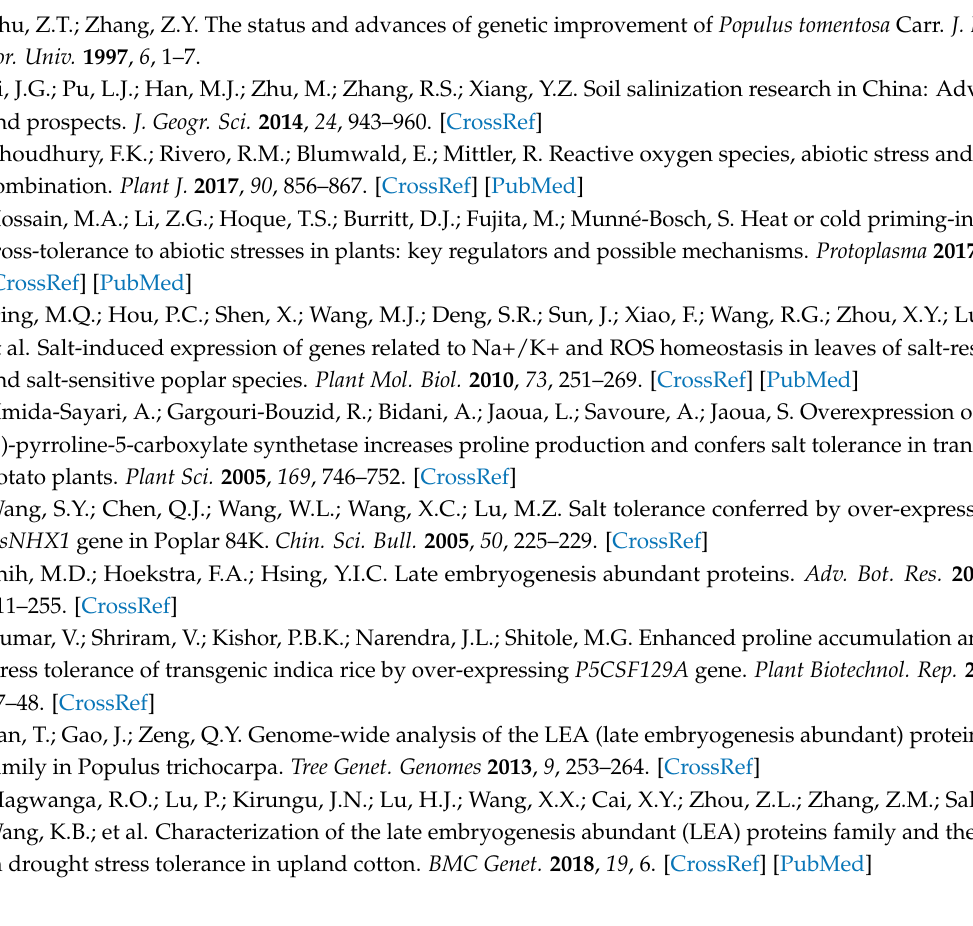
Table S1: The average electrical conductivity of substrate; Table S2: Transcriptome comparison statistics; Table S3: The functional analysis of differential expressed genes in transgenic poplar under salty